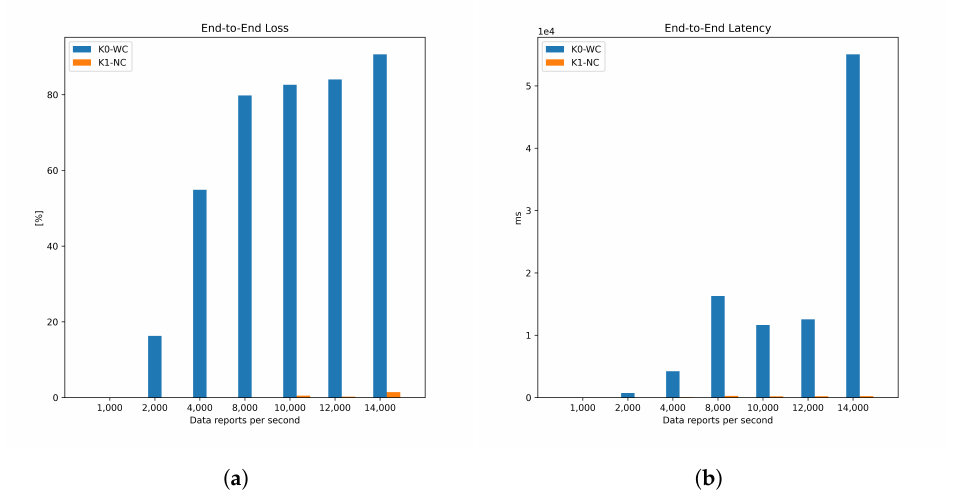
Figure 7. Implementation performance measured as loss rates and latency, for each implementation and Data Reports’ rate. ( a ) Loss rates. ( b ) Average end-to-end